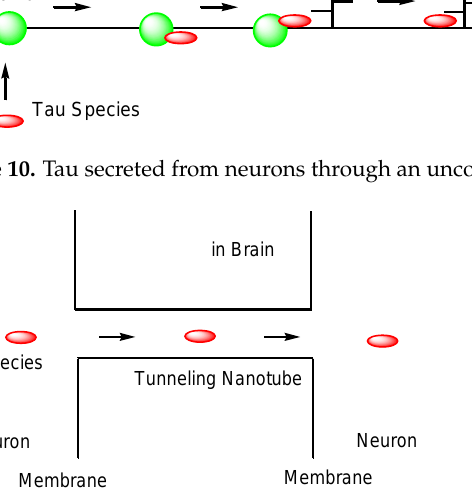
Figure 11. Tau cell-to-cell transportation through tunneling nanotubes.